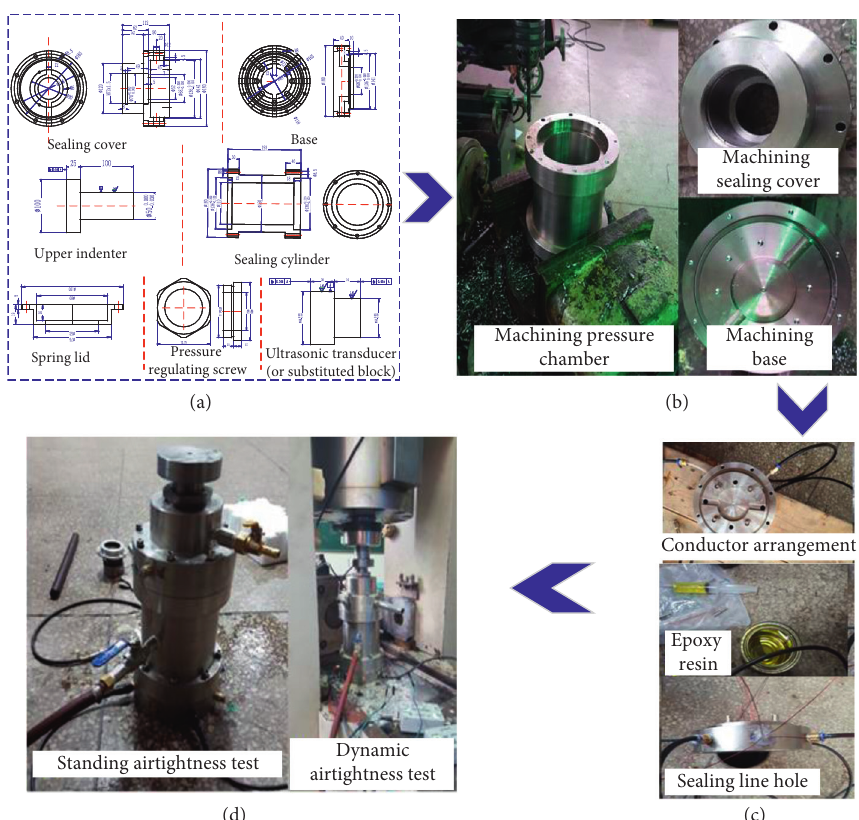
Figure 3: Schematic of the development process of the new gas-solid coupling loading device. (a) Device design. (b) Part processing. (c) Air tightness test. (d) Line